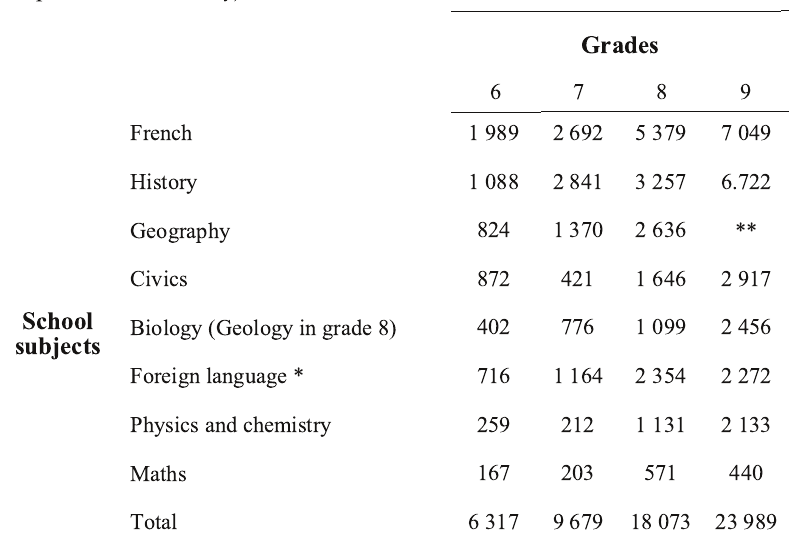
Inventory ofvocabulary in textbooks of4 levels ofcollège according to subjects (except usual